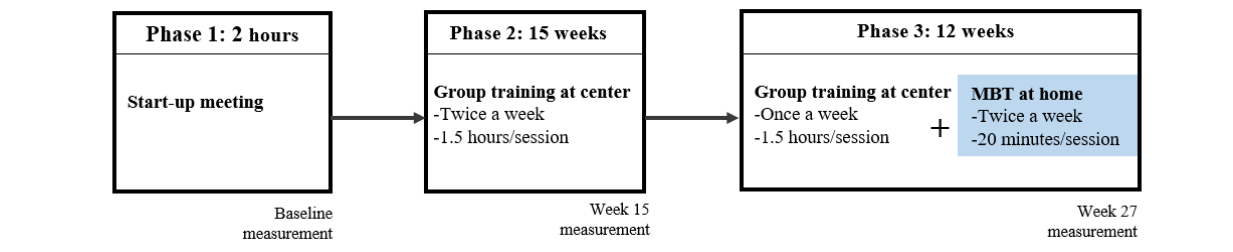
Figure 3. Pilot study